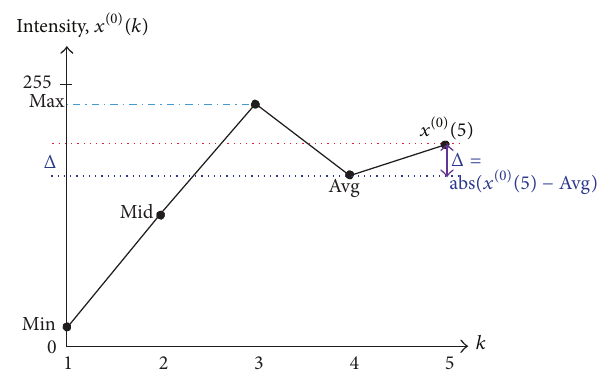
Figure 1: The calculation of Δ based on GM (1,1) prediction model.